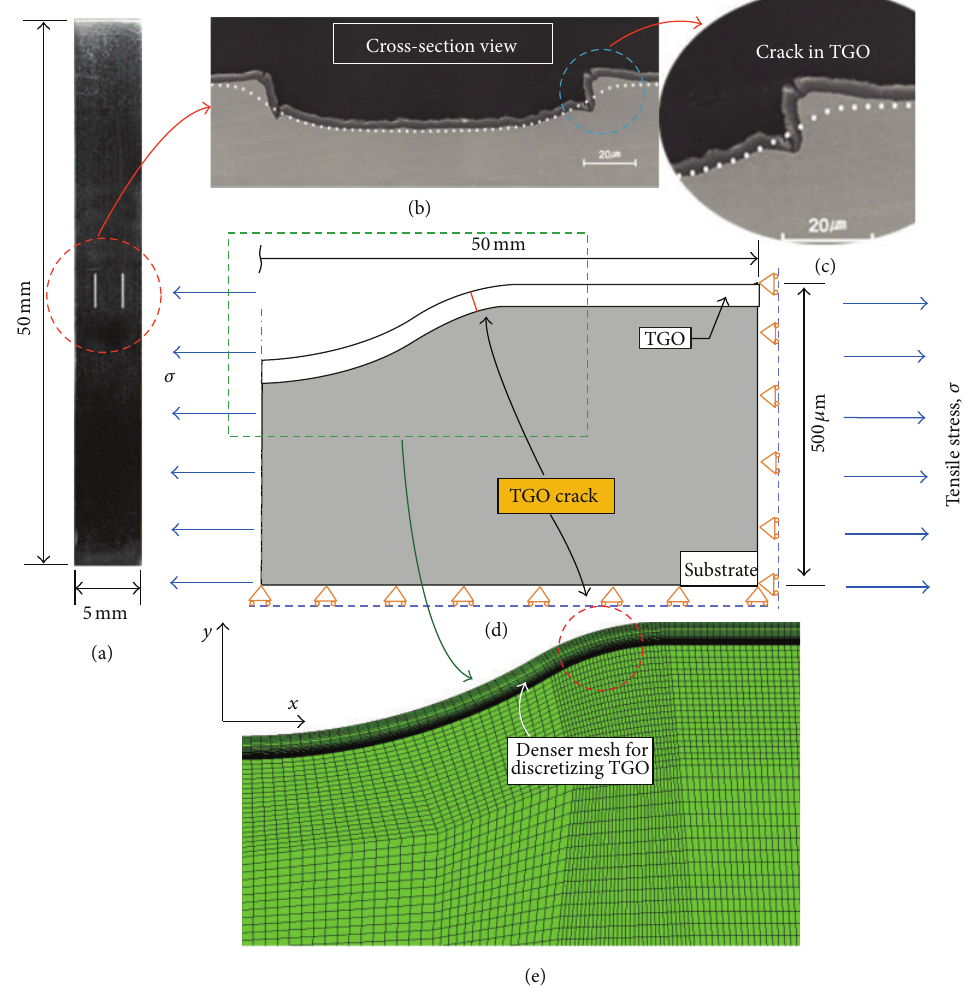
Figure 3: The modeling history and FEM model: (a) the rectangular specimen. (b) The cross-section view for the specimen. (c) The amplified view for the crack in TGO. (d) The boundary condition for FEM model. (f) The mesh for FEM model.